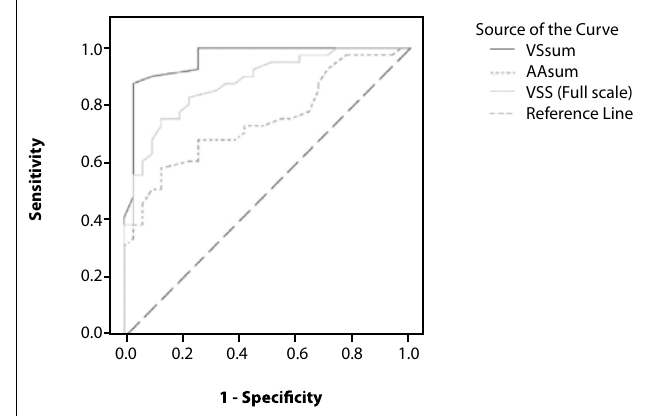
Fig. 4. The ROC curve obtained for the AVSS, including both the VER and AA